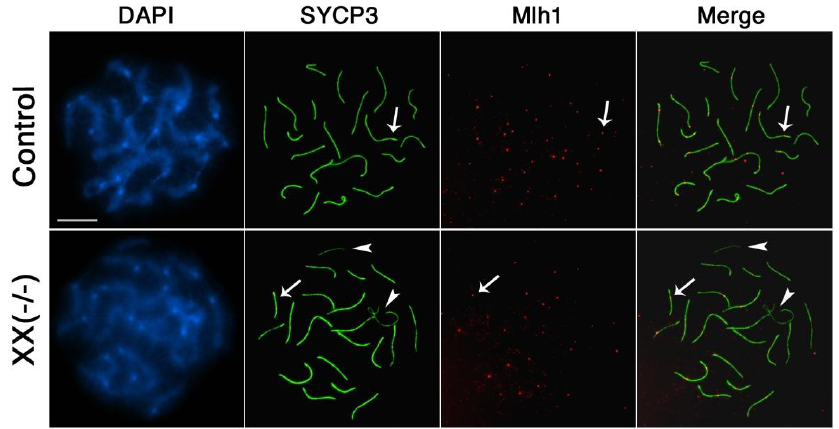
Figure 7. Crossover formation in mutant Cbx2 (XX−/−) oocytes. Control oocytes (upper panel) as well as oocytes recovered from mutant Cbx2 (XX−/−) fetuses (lower panel) at 18.5 dpc exhibit 1-2 Mlh1 foci (red) per fully synapsed chromosome bivalent (arrows). In contrast, asynapsed meiotic chromosomes in pachytene stage Cbx2 (XX−/−) oocytes lack Mlh1 foci due to failure to establish homologous recombination sites (arrowhead). DNA is shown in blue. Scale bars = 10 